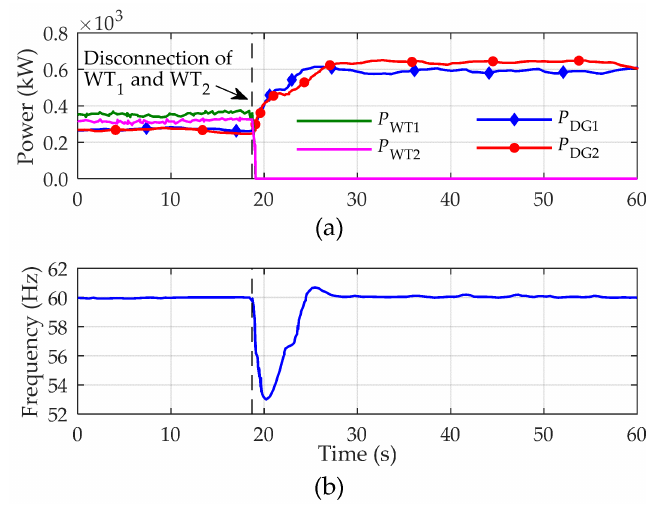
Figure 5. Real contingency scenario at the SCHPS: ( a ) Power generation; ( b ) Grid frequency.